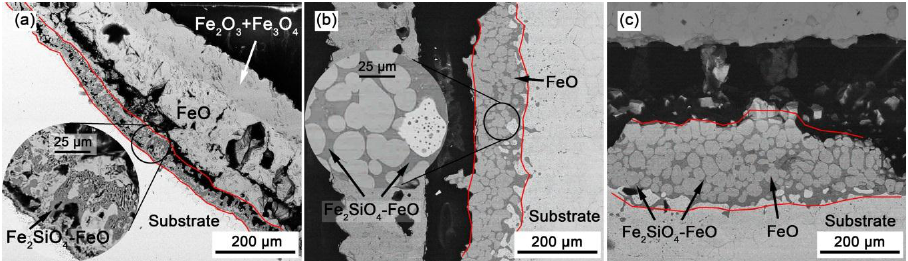
Figure 3. The typical morphology of Fe 2 SiO 4 –FeO in Routes 1-3: ( a ) Route 1, without melting; ( b ) Route 2, melting for 10 min; ( c ) Route 3, melting for 30 min.